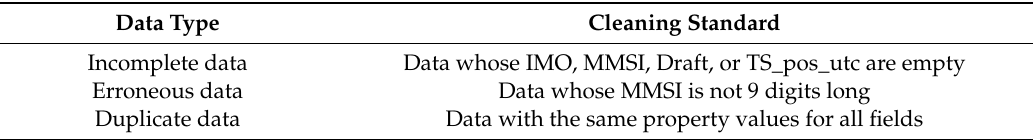
Table 2. Data cleaning standards.